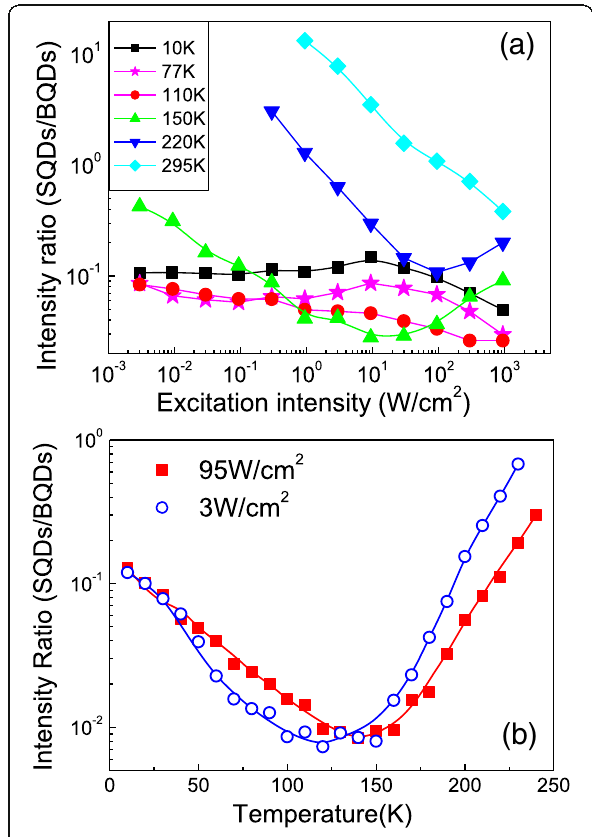
Fig. 5 a The integrated PL intensity ratio (SQDs/BQDs) with respect to excitation intensity. b The integrated PL intensity ratio with respect to temperature for both low and high excitation intensity of 3 W/cm 2 and 95 W/cm